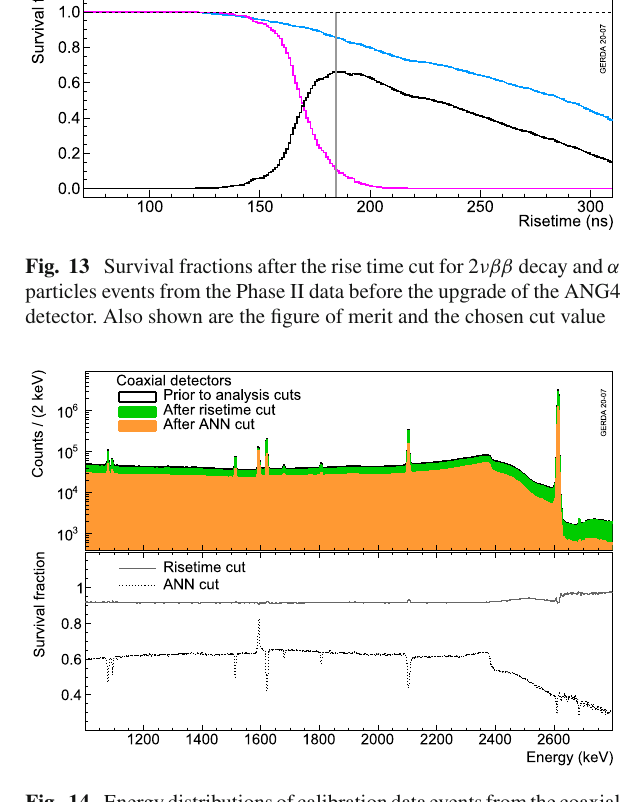
rejection of the Compton continuum events at Q ββ after the 2018 upgrade due to an improved signal cable management, an overall 3% level stability in PSD performance is observed over the course of Gerda Phase II. Compared to Gerda Phase I [10], on average a 7% relative worsening is observed, mostly attributed to the different electronics scheme, hence different noise. The risetime cut also shows a very stable behavior during this